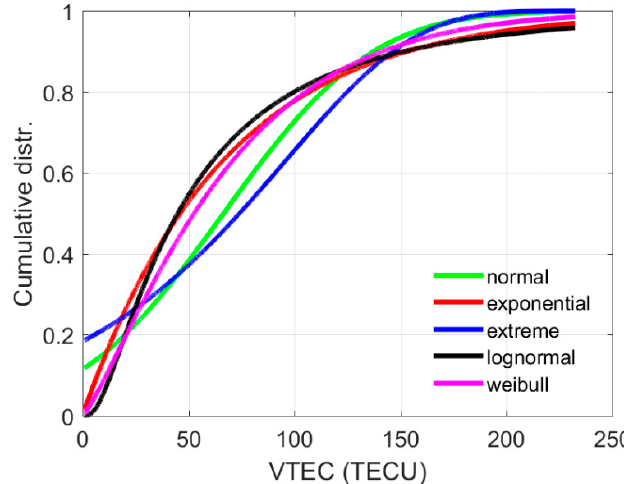
Figure 5. Cumulative probability distributions (Normal, Exponential, Extreme value, Lognormal, Weibull) for vertical TEC from the station HNLC at 30 October 2003. Table 3. Maximum TEC values, obtained from inverse cumulative density function (CDF) for a probability bound of 10 − 7 (derived from data of 3 IGS stations from 30 October 2003).